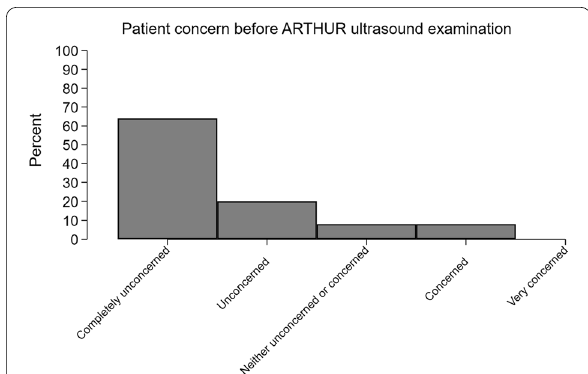
Fig. 5 Patients concern about being scanned by ARTHUR before the